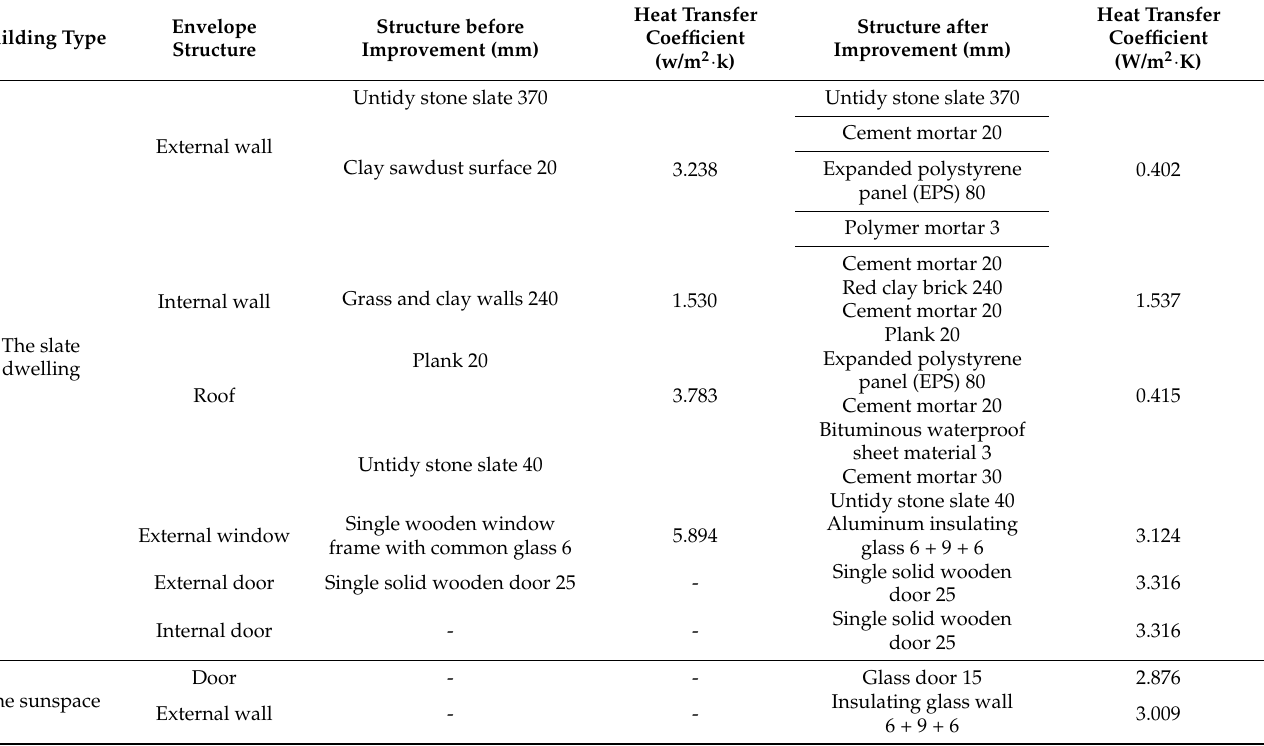
Table 4. The comparison of envelope parameters of the slate dwelling before and after